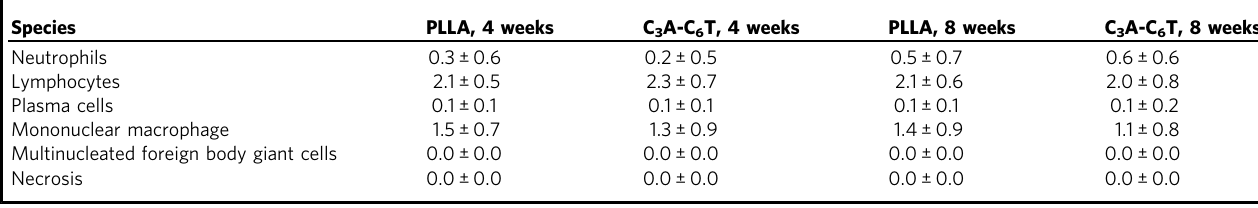
Table 2 Analysis of fi brous capsule granuloma formation and in fl ammatory cell presence for C 3 A-C 6 T and PLLA implanted samples using ISO 10993 standard scoring ( n = 6, ± represents 1